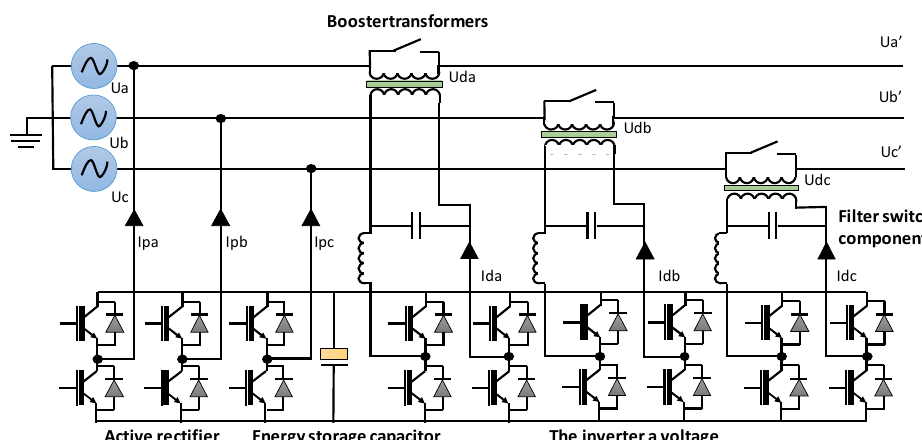
Figure 3. Schematic diagram of the DVR conditioner.